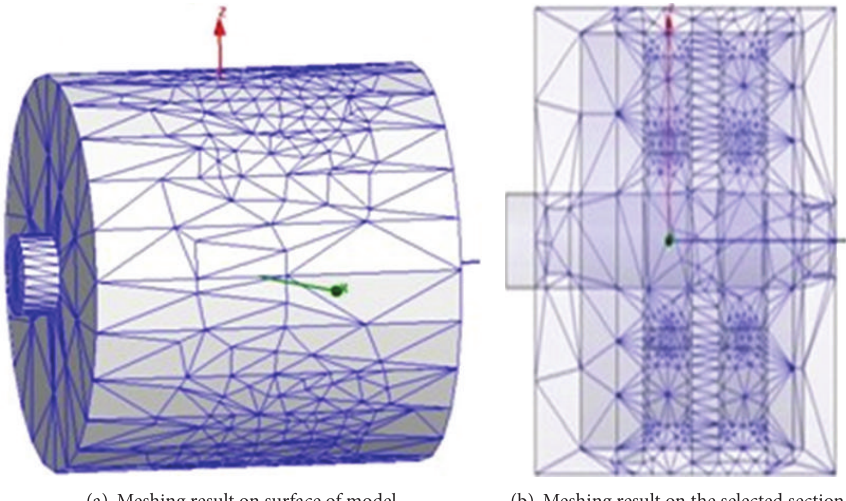
Figure 3: Chart of 3D meshing results.